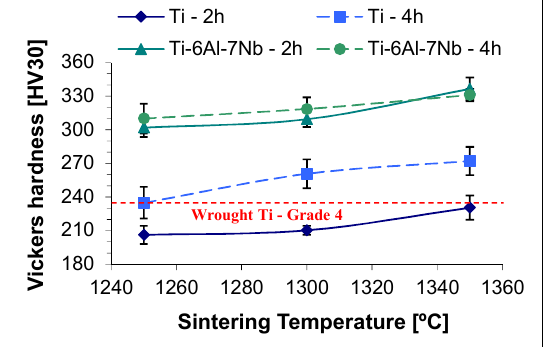
Figure 4. Variation of the Vickers hardness of the P/M Ti and Ti-6Al-7Nb alloy with the sintering temperature for different dwell times.